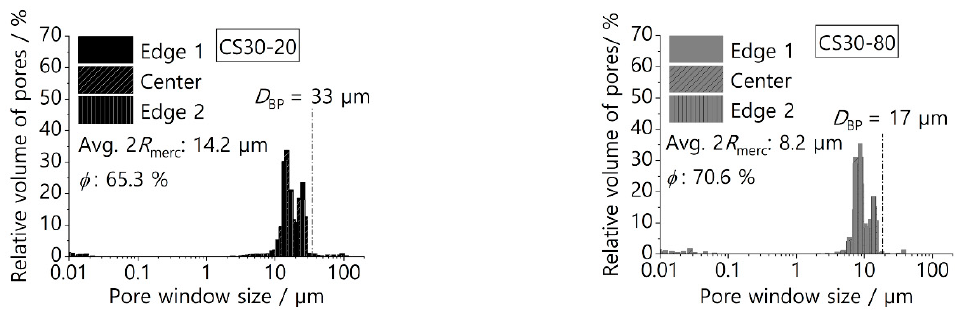
Figure 6. Hg intrusion porosimetry diagram for samples with a solid loading of 20 wt% for different freezing temperatures. Dashed lines indicate the biggest pore window size calculated based on bub- ble point pressure 𝐷 (cid:2886)(cid:2900) .